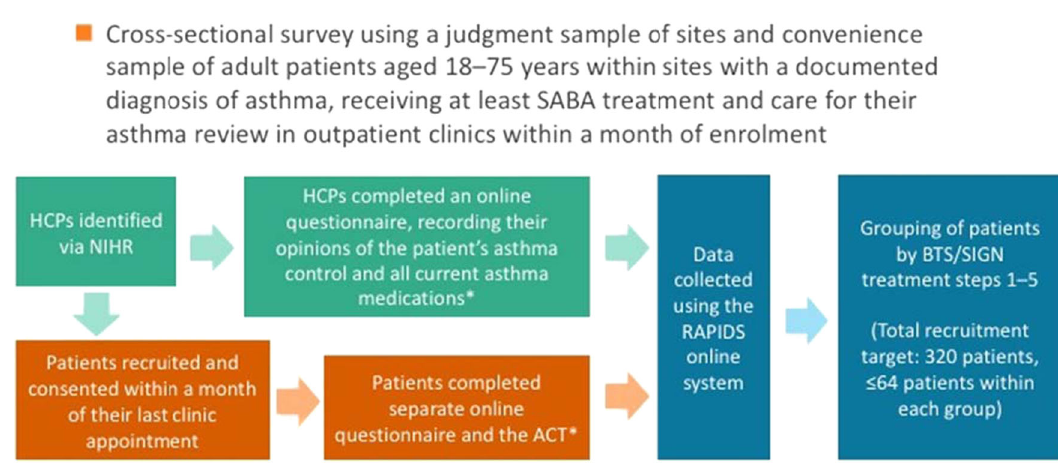
Fig. 5 Study design. ACT asthma control test, BTS/SIGN British Thoracic Society/Scottish Intercollegiate Guidelines Network, HCP healthcare professional, NIHR the National institute for Healthcare Research, SABA short acting ß-agonist. *All assessment were conducted at a single time point, a cross-section in time. At this time, the patient completed the ACT, demographic data and perception of their asthma control in the period re fl ected in the ACT. Recruiting physicians completed information about the patient's medications and their perception of the patient's asthma control for the period covered by the ACT. No intervention or medication was assessed in this study. BTS step 1 = Mild intermittent asthma, step 2 = Regular preventer therapy, step 3 = Initial add-on therapy, step 4 = Persistent poor control, step 5 = continuous or frequent use of oral